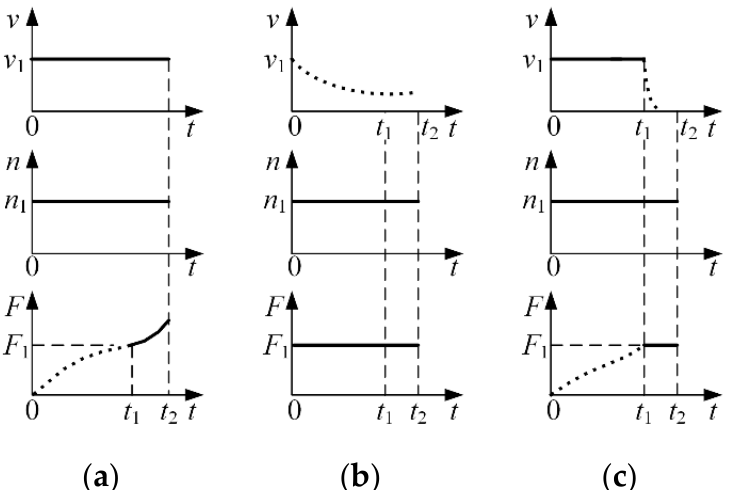
Figure 9. Schematic diagram of the speed–time and force–time curves of the three process-loading control methods: ( a ) Displacement–time control; ( b ) Force–time control; ( c ) MSCL control. Based on the analysis of the above two process-loading control methods, a new process-loading control method is proposed in this paper to reduce staking quality